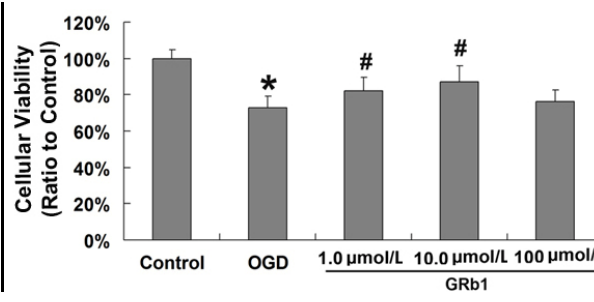
Figure 1. MTT assay of cellular viability. Pretreatment of GRb1 at the concentration of 1.0 µmol/L and 10.0 µmol/L significantly suppressed cellular death caused by OGD at 24